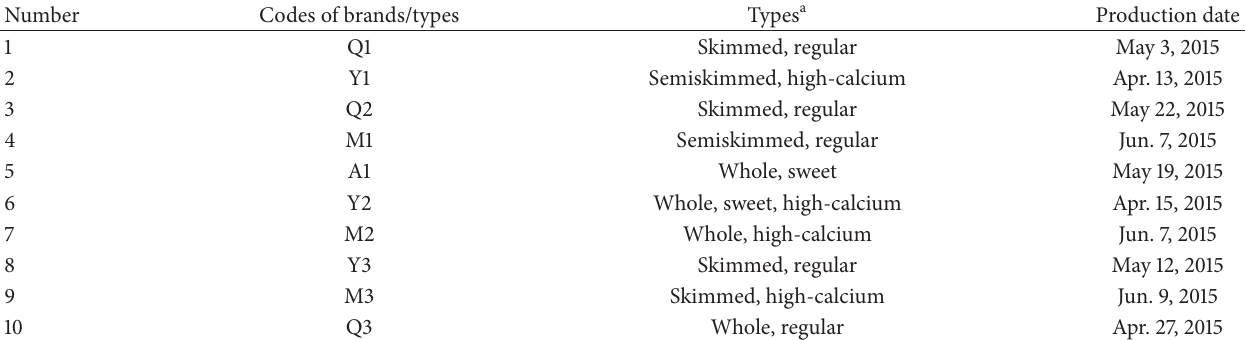
Table 1: The original milk powder samples of 10 different